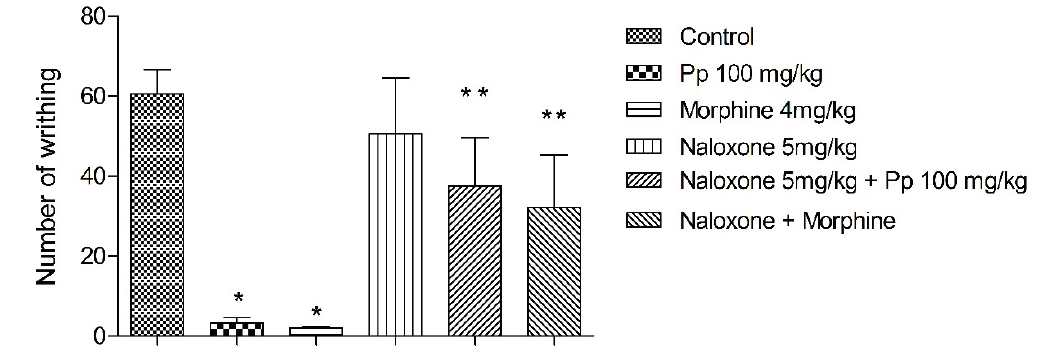
Figure 7. Mechanism of action. Each group represents mean ± s.e.m. of 5